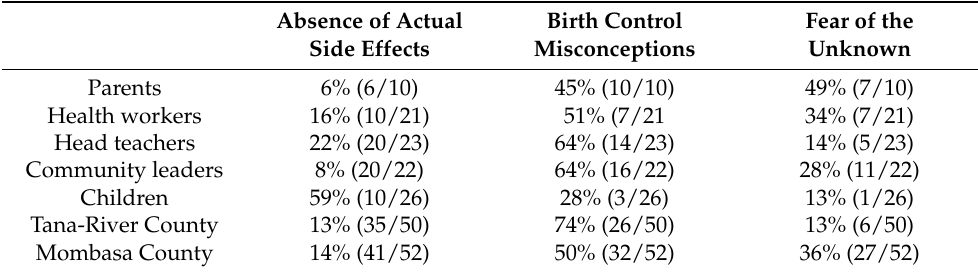
Table 1. Safety nodes from both